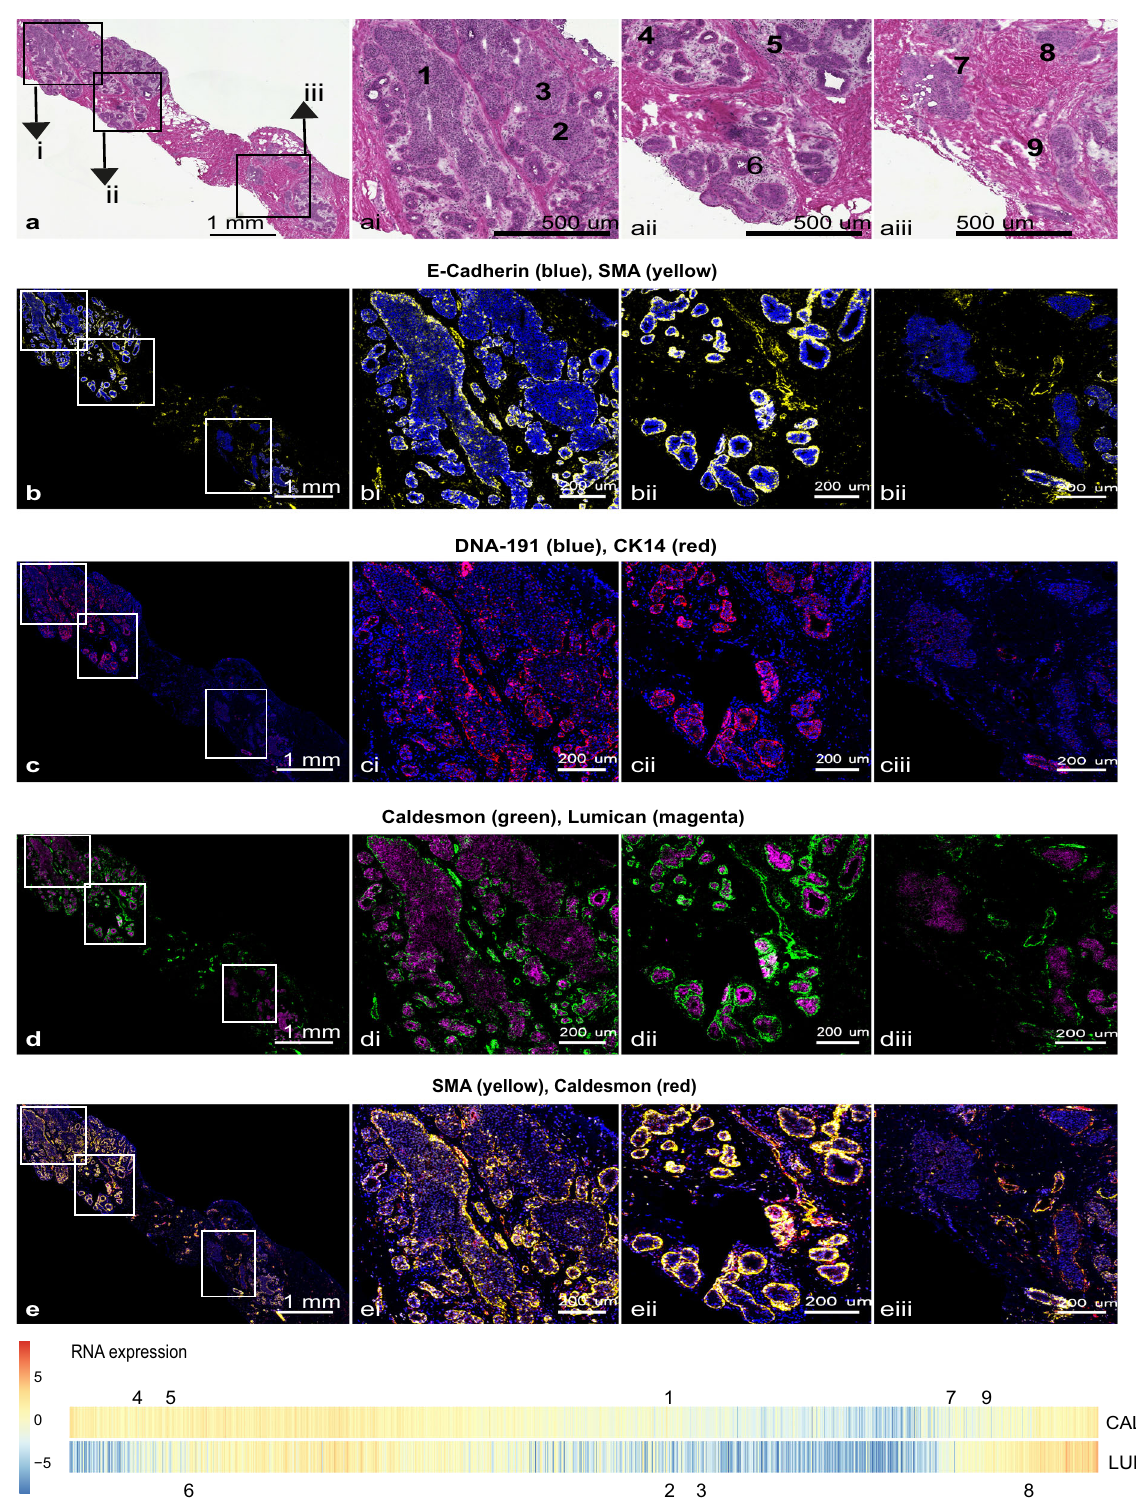
Fig. 4 Imaging Mass cytometry of ductal regions from patient sample CBZ (LumA subtype). The single slide was analysed in one continuous scan and magni fi ed regions retained the same intensity threshold. a shows H&E stained section, this same section was destained and used for IMC. Boxed areas indicate the corresponding magni fi ed regions shown in ai, ii and iii. b shows E-Cadherin and SMA, with corresponding boxed areas for i, ii and iii. c Shows CK14 and nuclear stain DNA-191, with corresponding boxed areas for i, ii and iii. d shows Caldesmon and Lumican and e shows SMA and Caldesmon, with corresponding boxed areas for i, ii and iii. Numbers on the H&E images indicate regions with expression data from adjacent sections. f shows the relative gene expression of Cald1 and Lum (as in Fig. 3b) with all samples ordered along the PCP continuum. Numbers above and below pair up with numbers in (a) and mark the position on the PCP continuum for the two (adjacent) data points corresponding to each